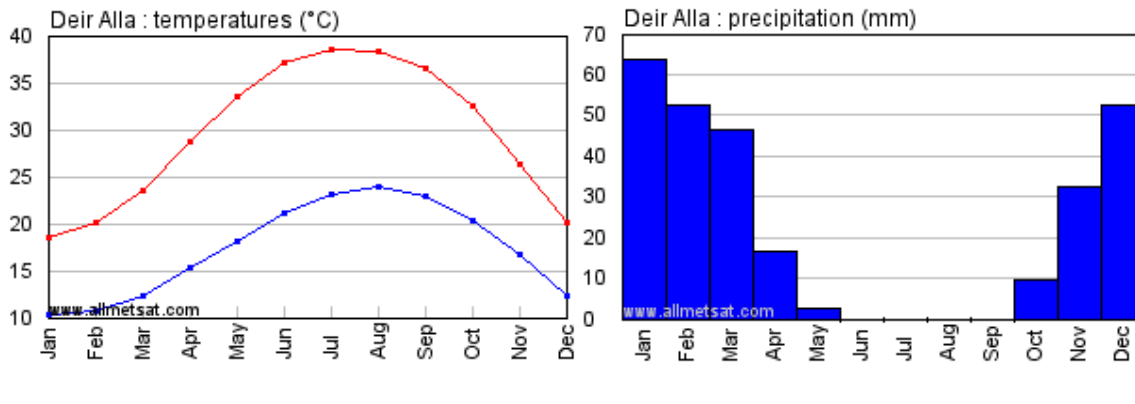
Figure 2. Average annual precipitation and temperature for Deir Alla region